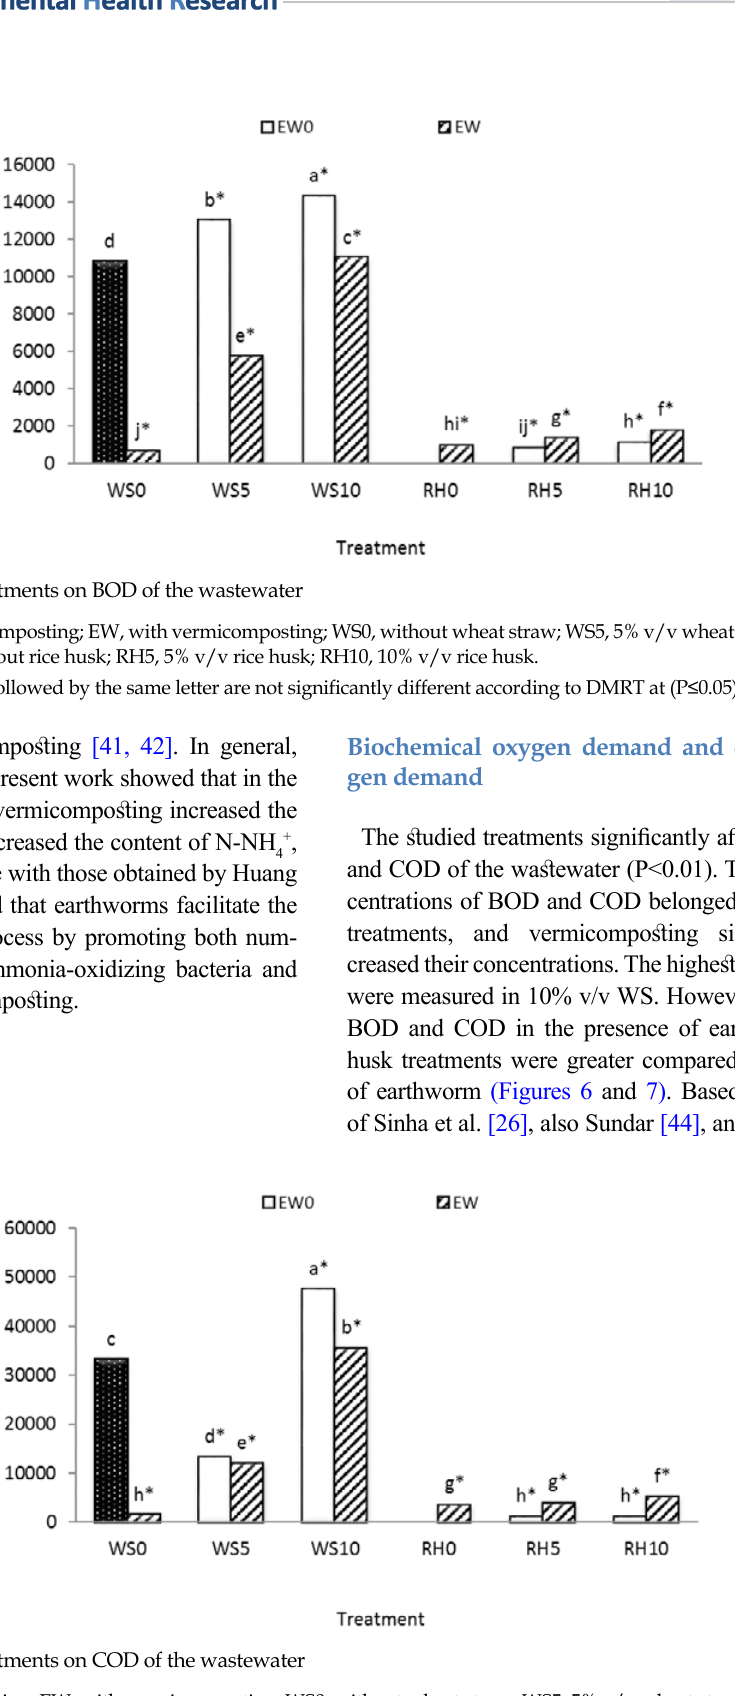
Jafarzadeh Ghahdarijani AR, et al. Vermifiltration of Municipal Sewage Influent. J Adv Environ Health Res. 2022;